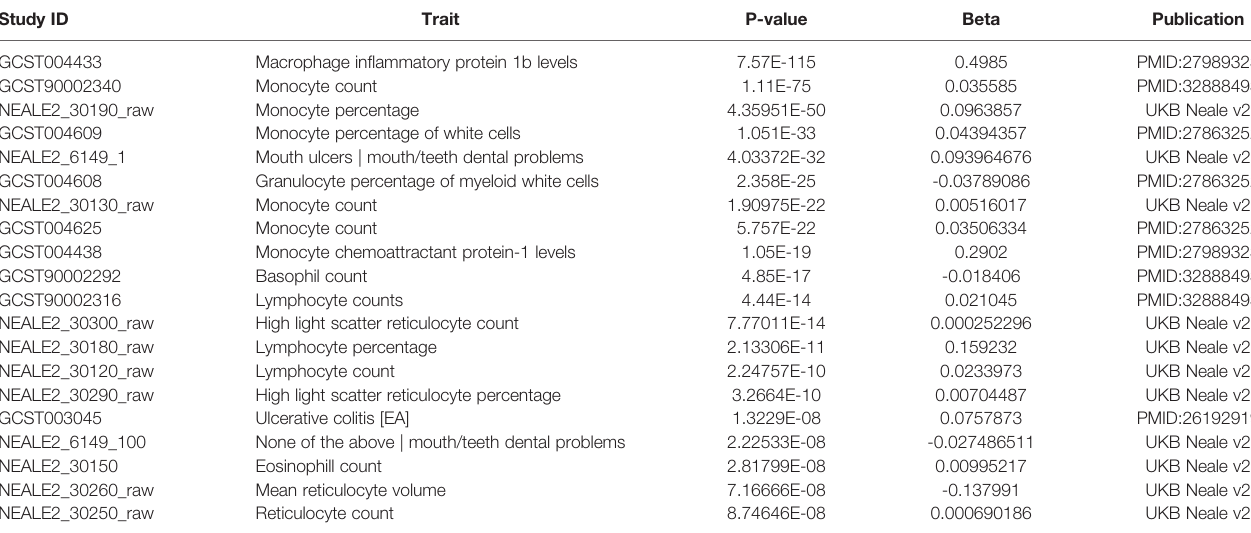
TABLE 2 | Traits associated with variants within the CCR5 gene region (chr3:46,353,419-46,409,888, hg38) of Figure 3B . Study ID